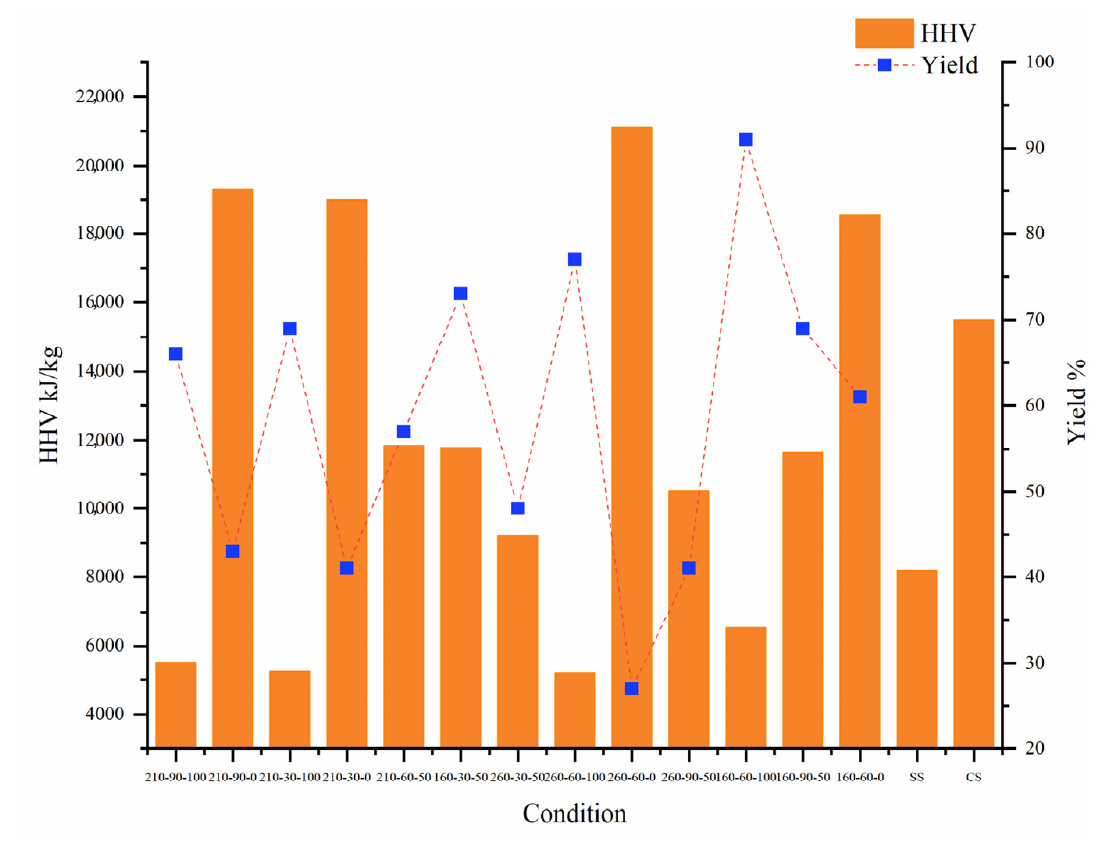
Figure 1. The HHV and yield of hydrochar and raw materials.